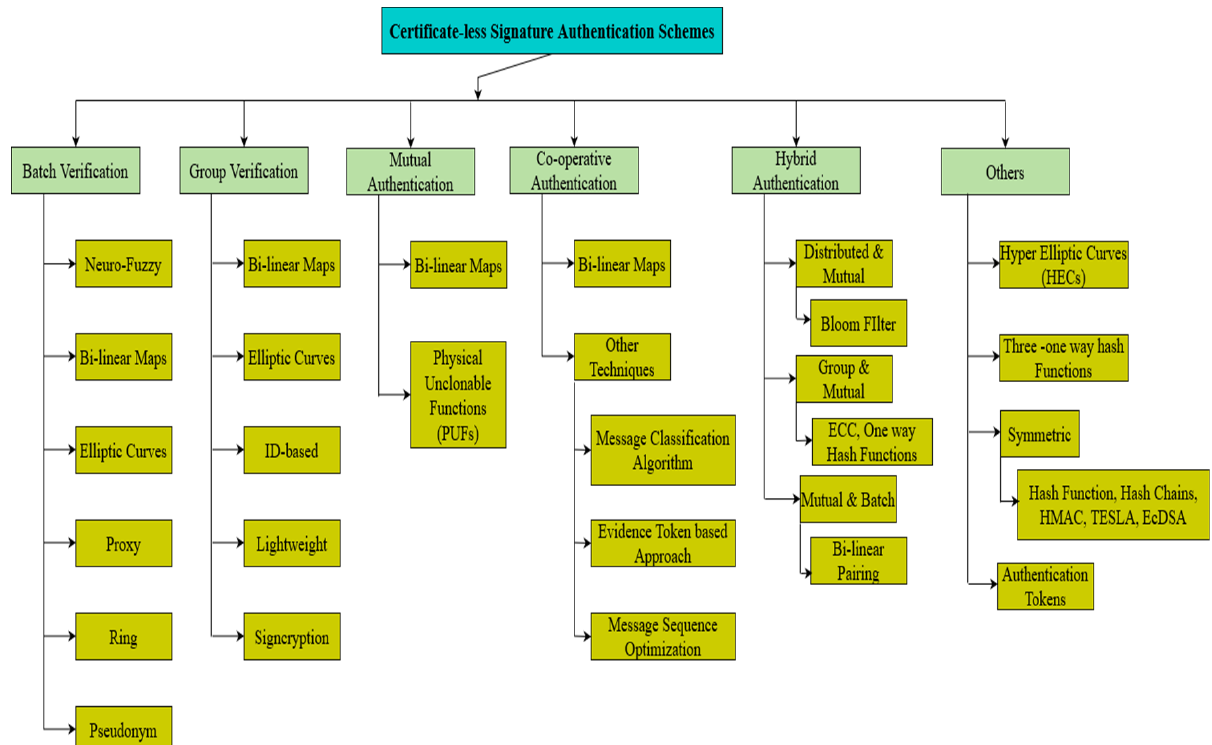
Figure 2. Classification of certificate-less authentication schemes (CLAS).